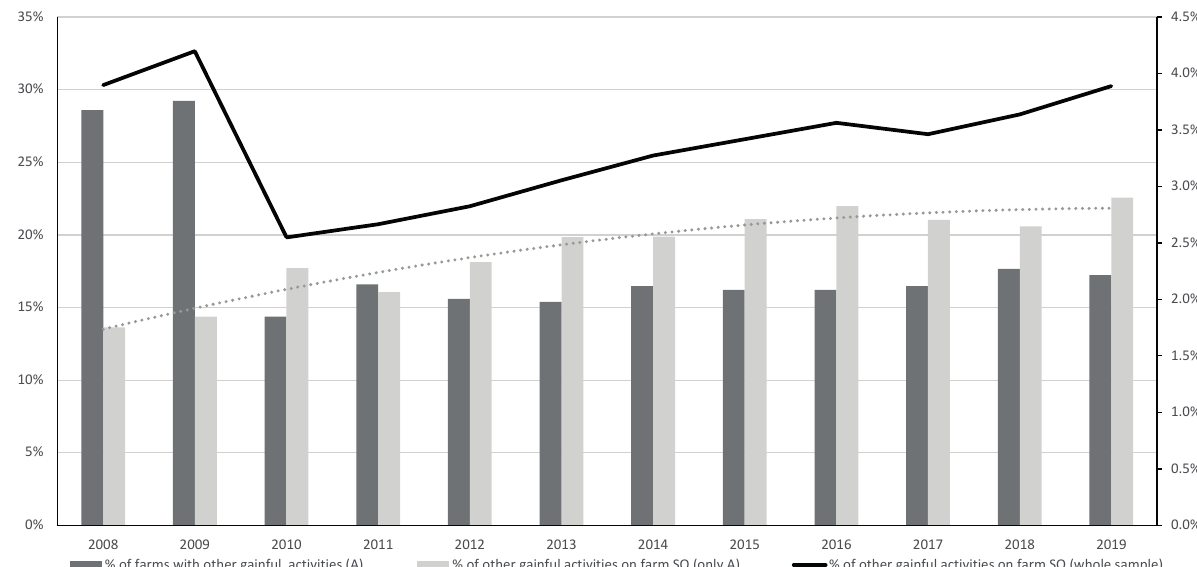
Figure 10. Evolution of the farms and of the incidence on farm Standard Output of other gainful activities within the Italian FADN bal- anced